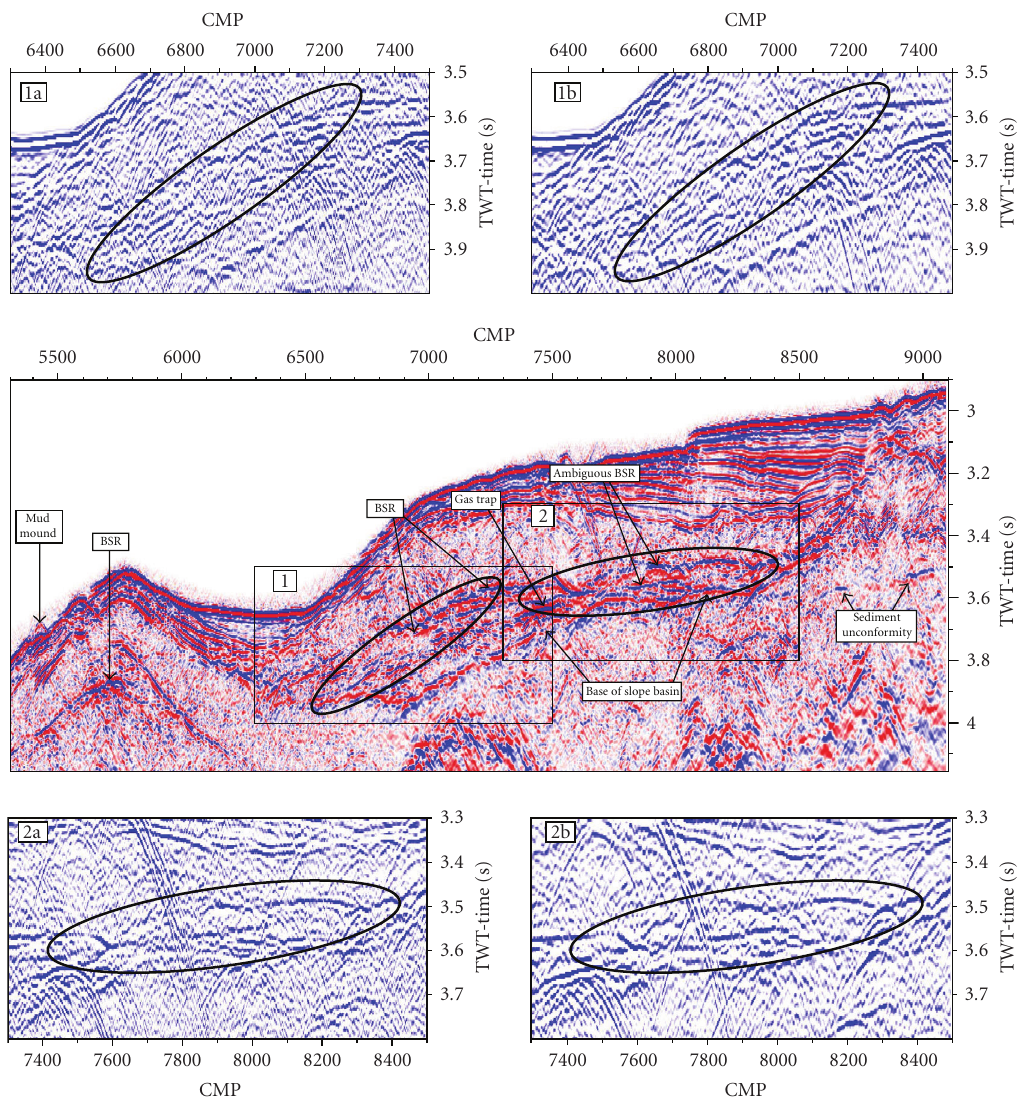
Figure 6: Centre: the time-migrated section between CMP 5300–9100 shows the middle slope of profile BGR99-46. Top and Bottom: close ups 1a and 2a are the near o ff set CMP stacks (141m–766 m) with incident angles of ∼ 1.5 ◦ –9.7 ◦ . Close ups 1b and 2b are the far o ff set CMP stacks (2641m–3266 m) with incident angles of ∼ 25.9 ◦ –37.4 ◦ . The colorscale for the o ff set stacks is modified to emphasize negative reflections. The areas of interest are marked with black